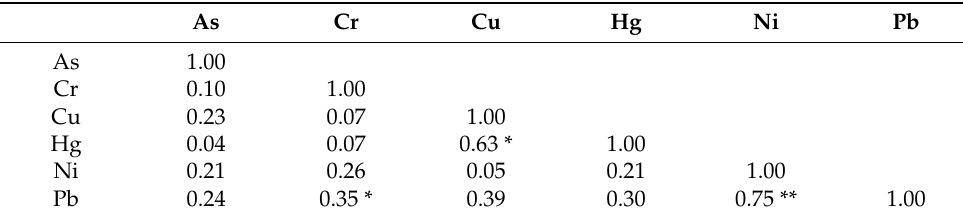
Table 8. Pearson’s correlation coefficients for the PTE content in the soil samples. As